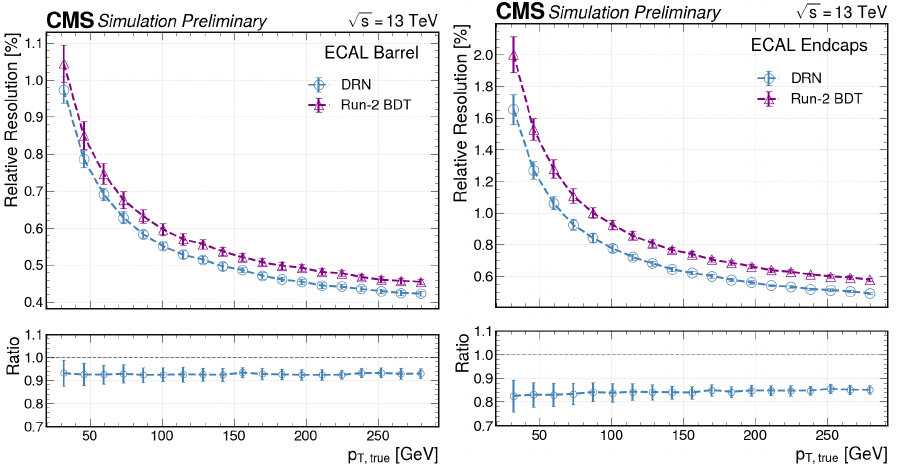
Figure 5. Dynamic Reduction Network (DRN) and Boosted Decision Tree performance in the ECAL barrel ( left ) and endcaps ( right ) as a function of generated transverse momentum. The DRN shows an improved resolution by